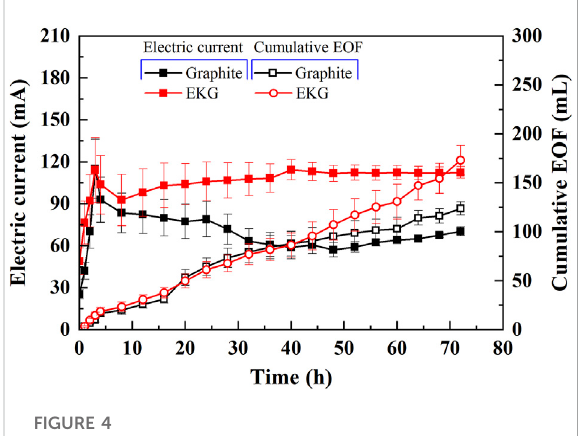
FIGURE 4 Variation of electric current and electroosmotic fl ow (EOF) versus time during the electrokinetic experiment subjected to the effect of electrode type. FIGURE 5